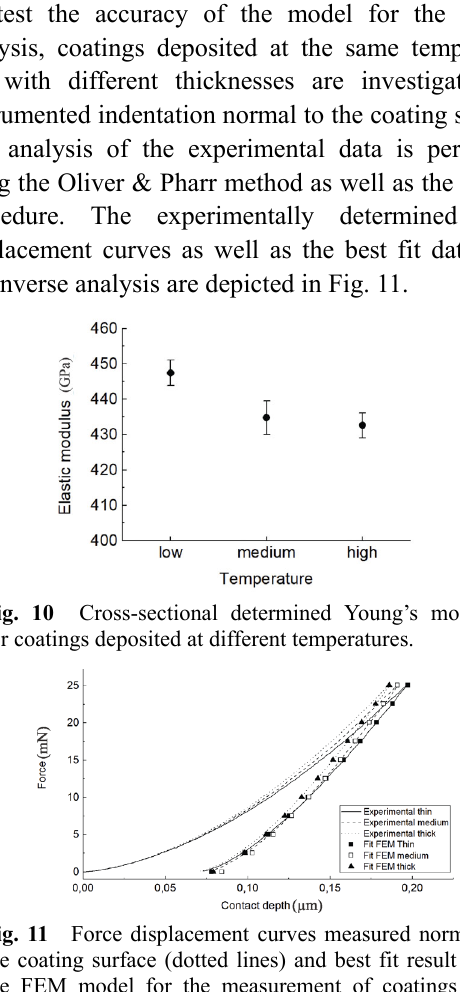
Fig. 9 Modulus measured in cross section at different coating thicknesses using Oliver & Pharr method.